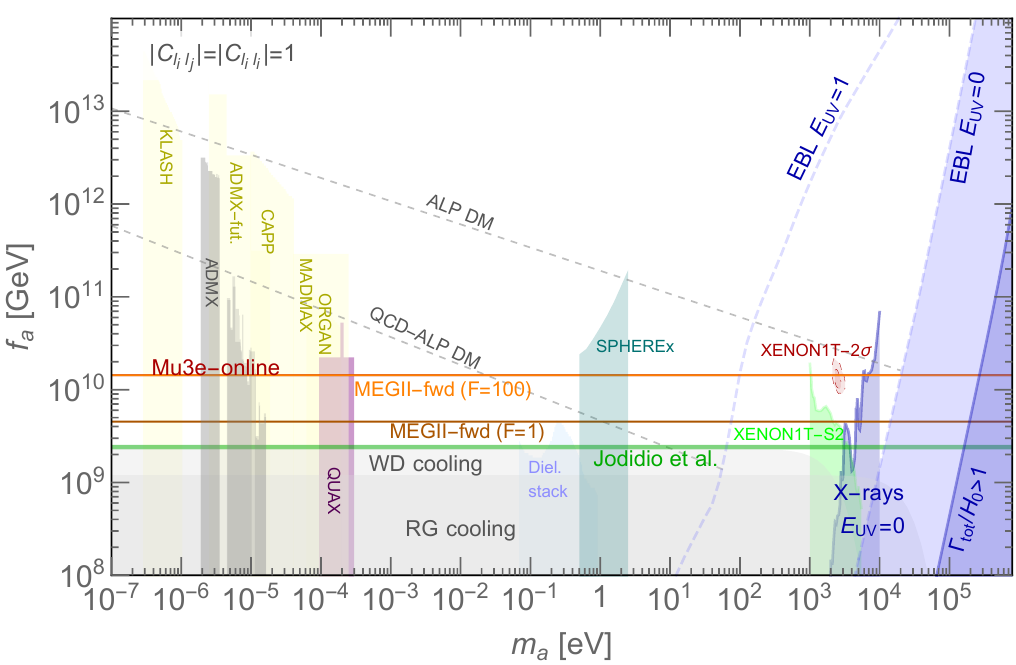
Figure 8 . The impact of present and future µ → ea searches compared to other light ALP DM searches, taking E = 1 , 0 as two representative examples. The green solid line shows the UV current best bound on the isotropic LFV ALP [9], the (dark) orange thin line gives our MEGII-fwd projection assuming F = 100 focusing enhancement (no focusing). The dark red line (overlapping with the orange thin line) shows the sensitivity of Mu3e-online analysis [42]. In the blue region enclosed by the solid blue line the ALP decays within the present Hubble time, while the region to the right of the dashed blue line is excluded by the extragalactic diffuse background light measurements for E = 0 , 1 . We also show the X-rays constraints for E = 0 [94, 95]. The red blob indicates UV UV where ALP DM could explain the XENON1T anomaly [96]. The dashed gray lines denote two scenarios where the observed DM relic abundance is due to ALPs produced trough the misalignment mechanism. On the upper line the ALP mass is temperature independent, cf. eq. (6.17), while on the lower line the temperature dependence is parametrically similar to the one for the QCD axion, cf. eq. (6.18). The gray shaded regions are excluded by the star cooling bounds, and the ADMX data [97–99]. The light green region is excluded by the S2-only analysis of XENON1T [100] and Panda-X [101]. The purple shaded region shows the future reach of axion-magnon conversion experiments such as QUAX [102–104]. Regarding the coupling to photons, the cyan band shows the future sensitivity of SPHEREx estimated in ref. [105], assuming ALP decay exclusively to two photons, while the yellow bands show the future sensitivities of resonant microwave cavities such as ADMX [106], CAPP [107], KLASH [108], and ORGAN [109], dielectric haloscopes such as MADMAX [110] and the reach of the dielectric stack proposal [111] is shown with light blue